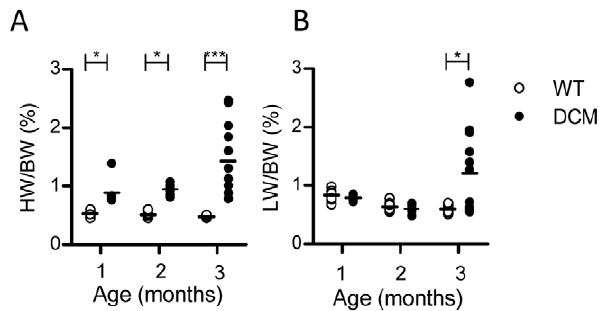
Figure 1. HW/BW and LW/BW ratios in individual WT and DCM mice at 1–3 months of age. A. HW/BW ratio. B. LW/BW ratio. Bars indicate means. n =7–12. *P , 0.05, ***P , 0.001 vs. age-matched